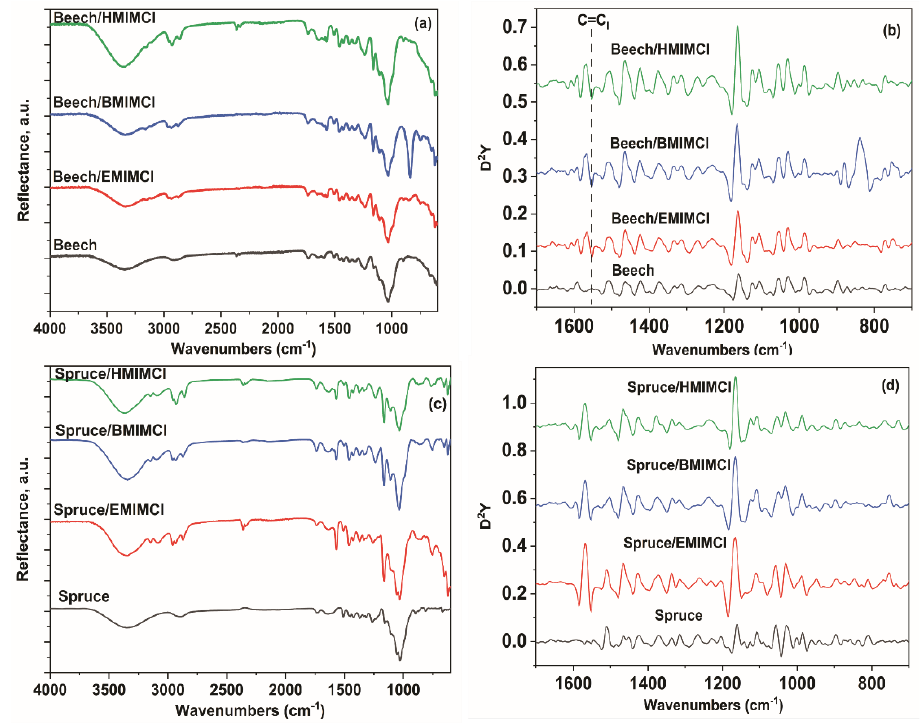
Figure 3. ATR-FTIR spectra of: ( a ) beech wood treated with alkylimidazolium chloride ILs; ( b ) second derivative spectra of beech treated with alkylimidazolium chloride ILs; ( c ) spruce wood treated with alkylimidazolium chloride ILs; ( d ) second derivative spectra of spruce treated with alkylimidazolium chloride ILs.